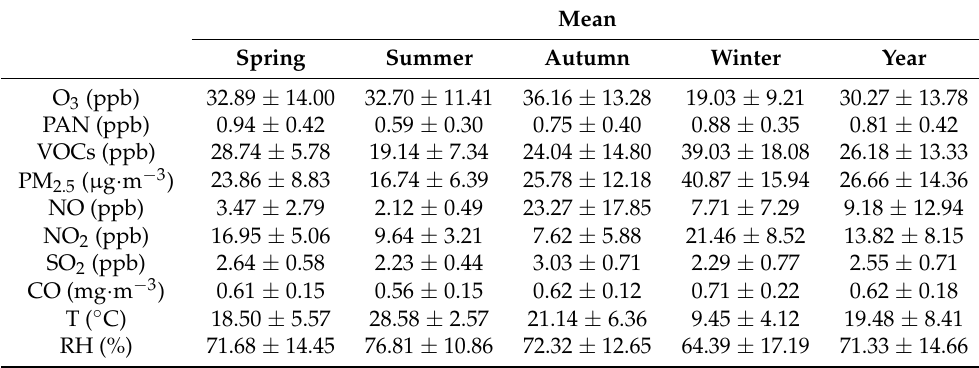
Figure 2. The daily mean of O 3 , PAN, VOCs, NO x , CO, SO 2 , PM 2.5 , and meteorological parameters (T and RH) from January–December 2021. ( a ) Time series of T and RH, ( b ) Time series of NO and NO 2 , ( c ) Time series of O 3 and PAN, ( d ) Time series of O 3 and PAN, ( e ) Time series of VOCs and PM 2.5 . The whole year is divided into four seasons. Table 1. Summary of mean concentrations of air pollutants and meteorological parameters during a full-year period in